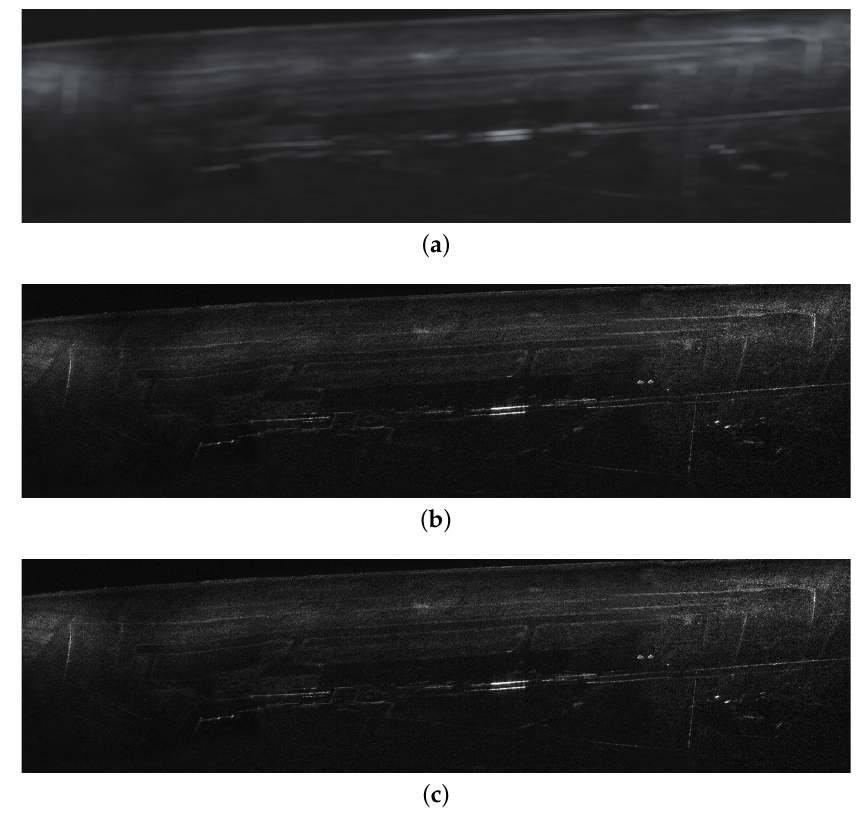
Figure 11. Imaging results of experimental data. ( a ) NLCS-based 2-D SVD algorithm with inaccurate movement information. ( b ) NLCS-based 2-D SVD algorithm with accurate movement information. ( c ) The proposed